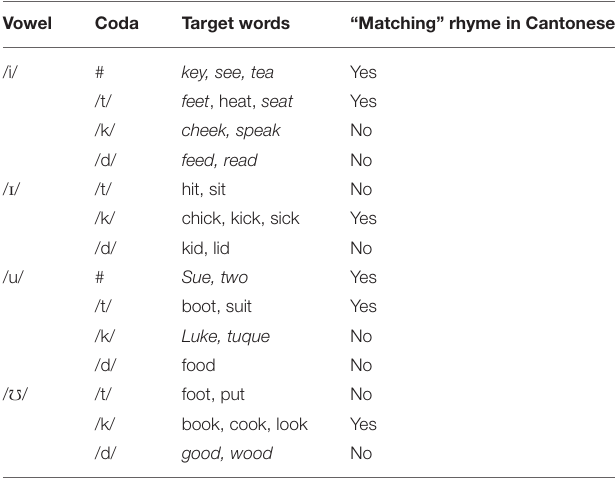
TABLE 1 | Stimulus items according to syllable